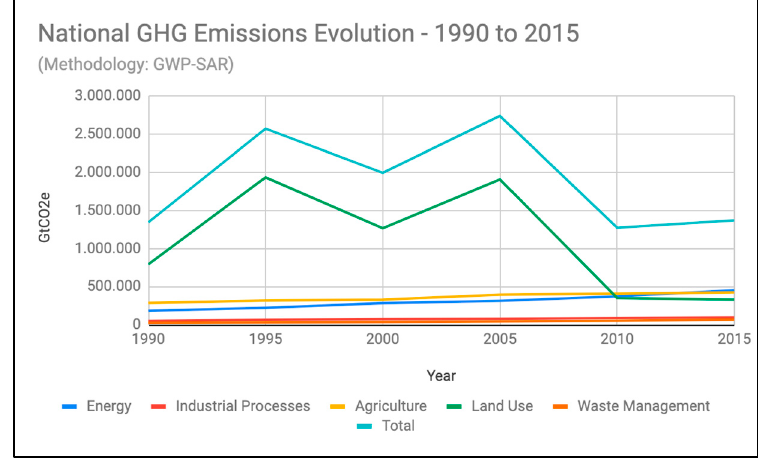
Figure 2. National-level GHG emissions (1990–2015) [40].